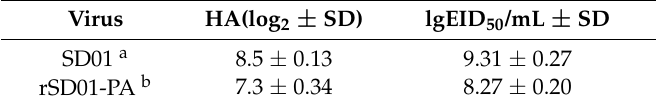
Table 1. Hemagglutination and infectious virus titers.